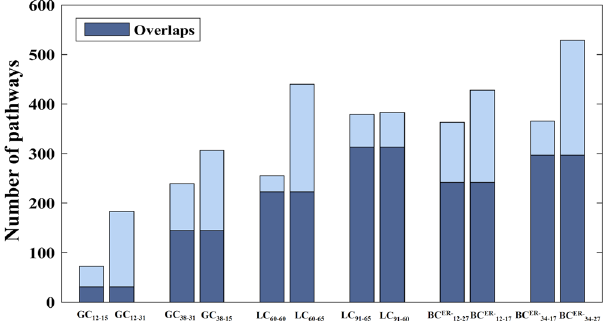
Figure 3. Numbers of significant MSigDB pathways detected for GC, LC, and